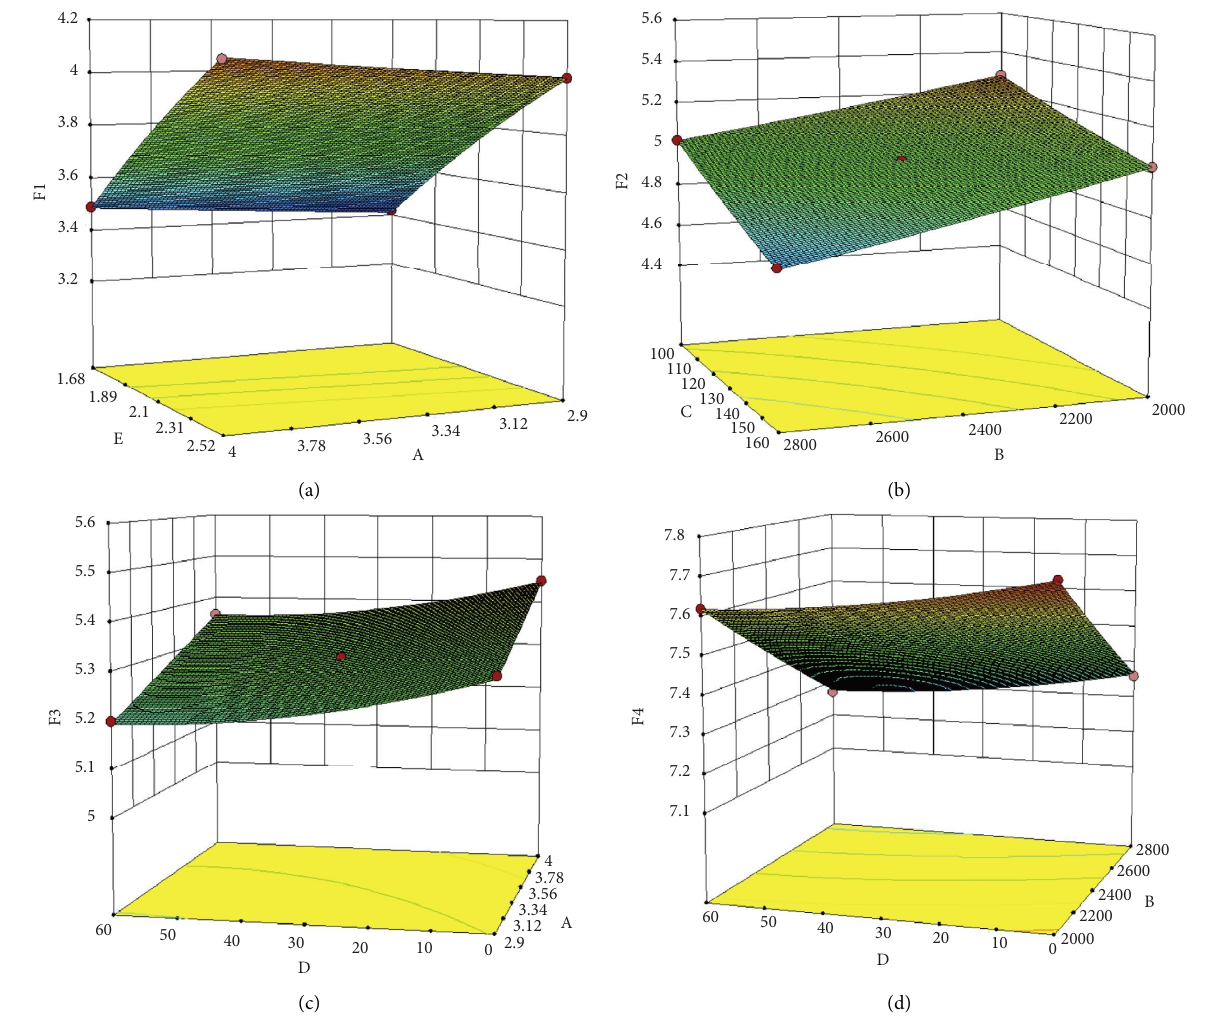
Figure 8: Regression response surface for each order of frequency. (a) f and AD response surface. (d) f